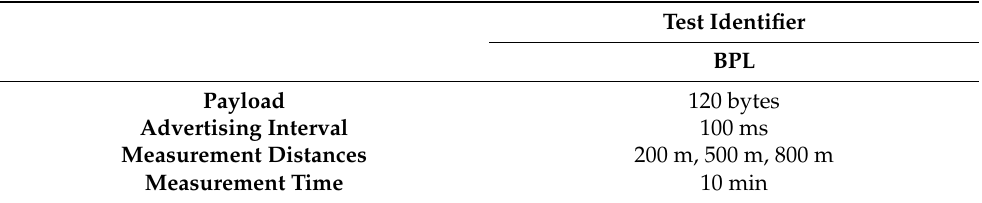
Table 7. I2V Test configuration coexistence LE_CODED long distance I2V scenario.